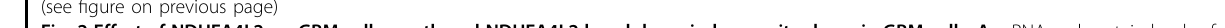
autophagosomes/autolysosomes than si-NC-treated cells (yellow arrows indicate normal morphology of mitochondria in GBM cells, red arrows indicate abnormal morphology of mitochondria in NDUFA4L2 knockdown cells; red stars indicate autophagosomes, and yellow stars indicate auto-